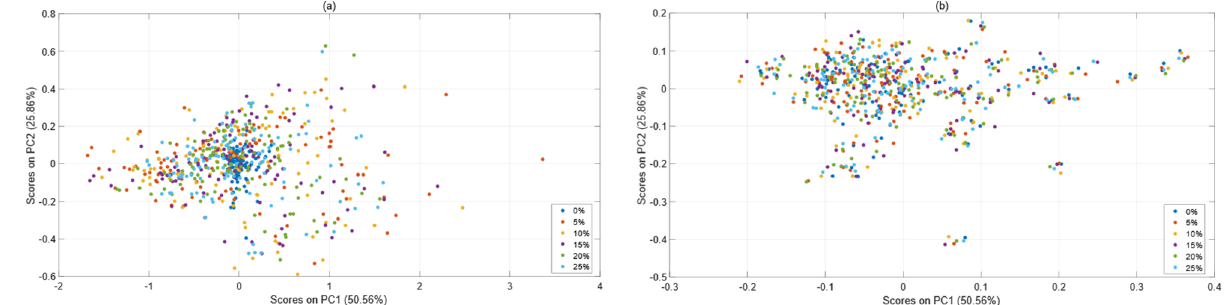
Figure 6. Distribution of PCA score values for soils with 0% (dry soil), 5%, 10%, 15%, 20%, and 25% moisture content ( a ) before and ( b ) after SST correction.